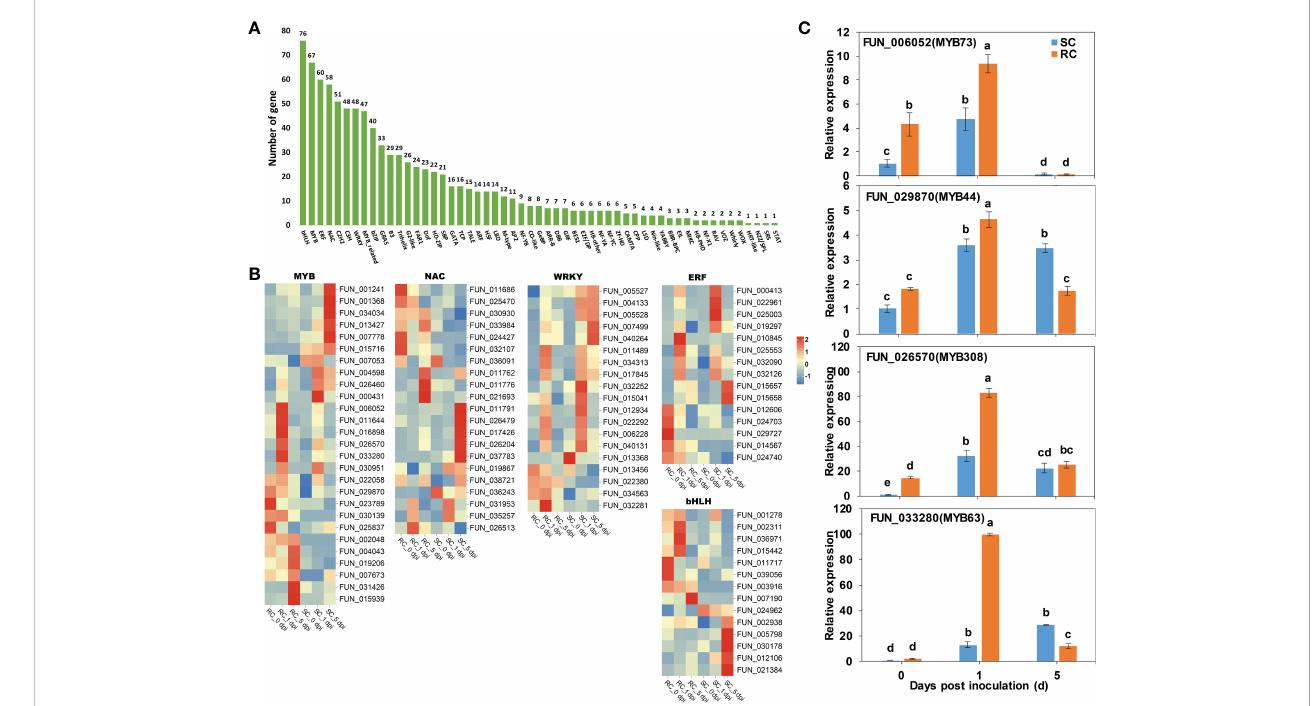
FIGURE 8 Analysis of transcription factors (TFs). (A) Number of TFs in SC and RC inoculated with A. alternata . (B) Heatmaps of DEGs encoding TFs, including MYBs, NACs, WRKYs, ERFs, and bHLHs. (C) RT-qPCR analysis to four MYB TFs involved in phenylpropanoid biosynthesis. Error bars represent standard deviation (n = 3). Different letters above the bars indicate signi fi cant differences at the 0.05 level according to Duncan ’ s multiple range